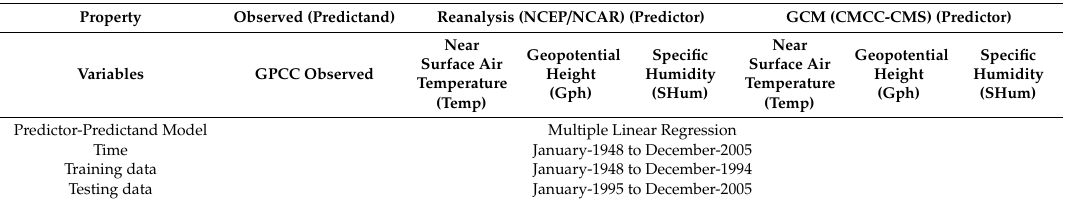
Table 1. Summary of Data / Methods.